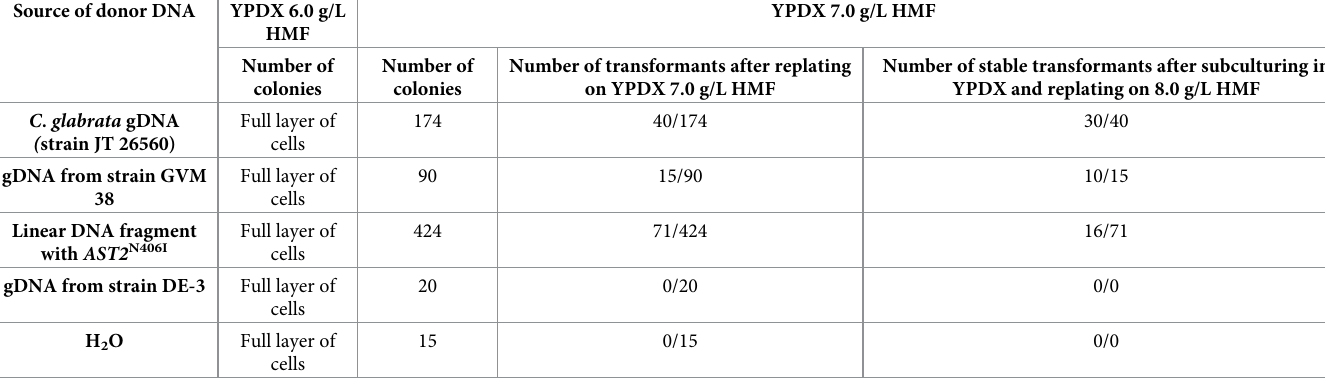
Table 2. Number of transformants after WGT of strain DE-3 and selection for improved HMF tolerance. Number of colonies on HMF-containing medium for each transformation condition with or without further subculturing of the colonies is indicated. All YPDX plates contained 6.5% D-glucose and 4.0% D-xylose. All visible colo- nies on YPDX 7.0 g/L HMF were replated on solid nutrient medium. The transformants that showed growth after replating, were subsequently subcultured in liquid YPDX without HMF for 10 serial transfers and then replated on YPDX with 7.0 g/L